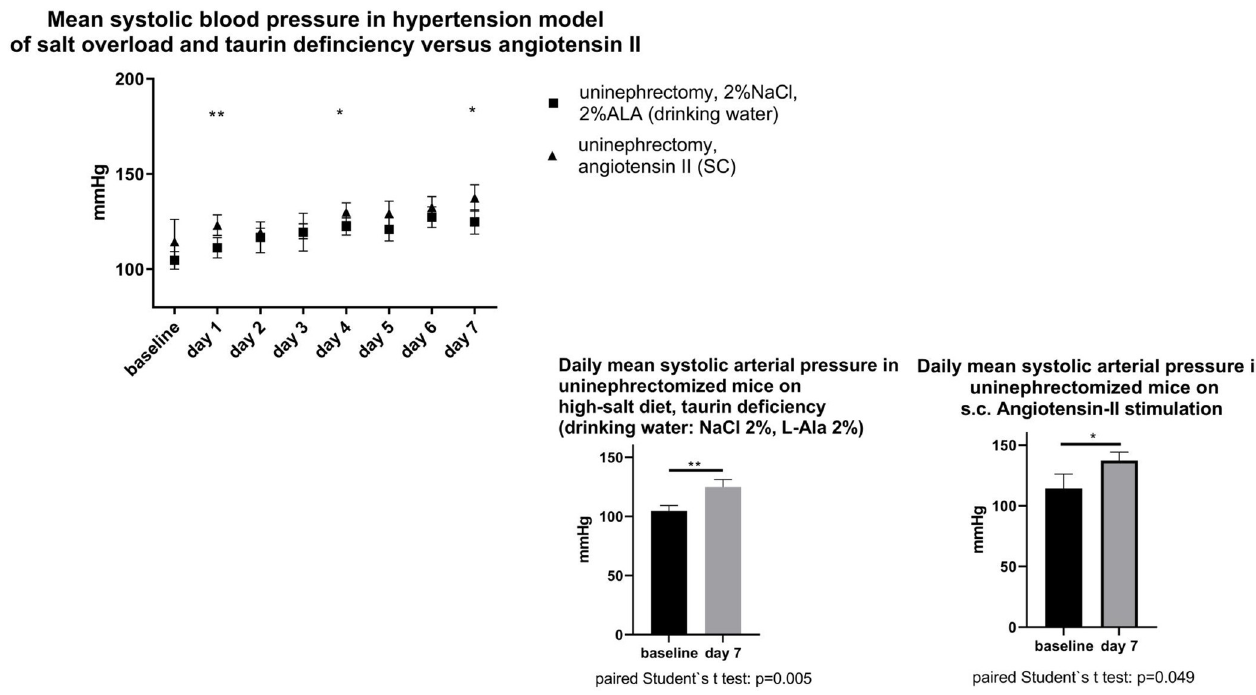
Fig 3. Upper panel: evolution of daily mean systolic blood pressure in uninephrectomized mice during hypertension-inducing interventions. a) oral sodium-chloride load and taurine deficiency (NaCl (2%) + L- alanine (2%)-enriched drinking water); b) angiotensin II: 1.4 mg/kg/d subcutaneously applied by osmotic minipump. Lower panel: direct comparison of daily mean systolic blood pressure within groups (baseline versus end of study).